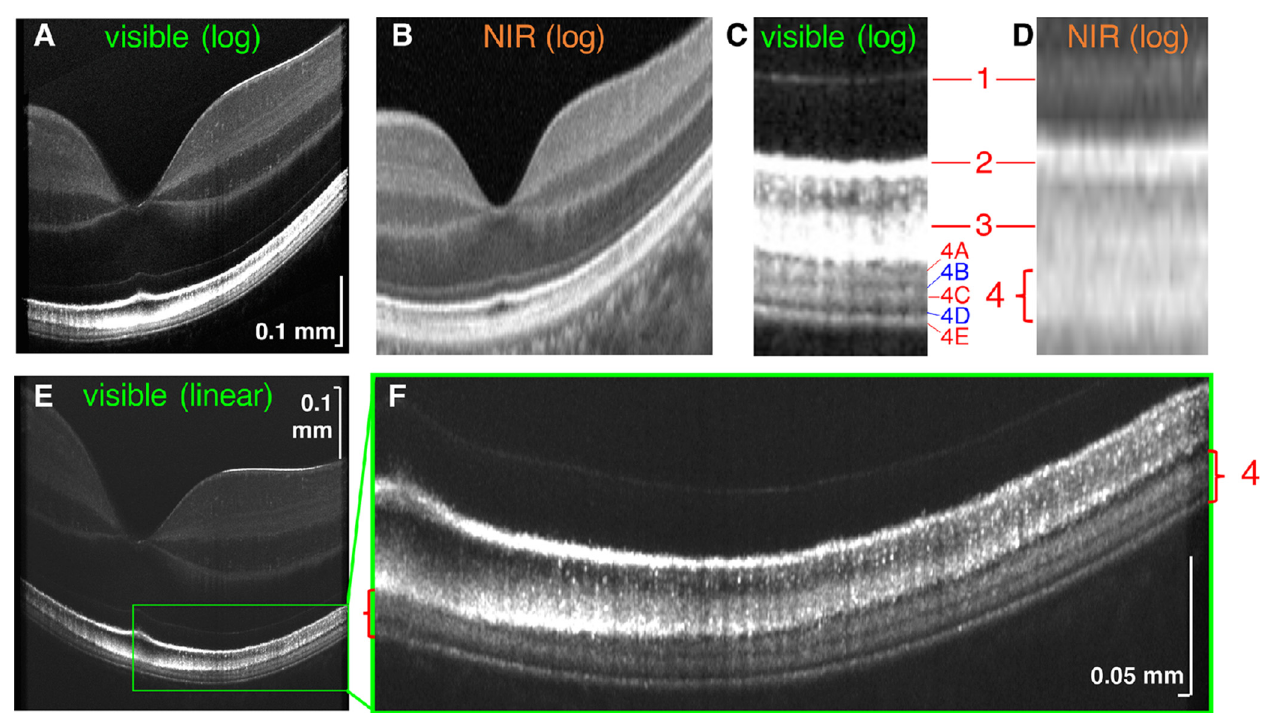
Figure 1. Visible light OCT (vis-OCT) imaging. Side-by-side comparison of vis-OCT ( A ) and commercial NIR-based OCT ( B ). ( C ) Magnified vis-OCT that shows outer retinal bands 1–4, with segmented hyperreflective bands and hyporeflective zones in outer retinal band 4, compared to magnified commercial NIR-based OCT ( D ). ( E , F ) Vis-OCT (linear scale). Reprinted with permission from Zhang et al. [18] . Visible Light Optical Coherence Tomography (OCT) Quantifies Subcellular Contributions to Outer Retinal Band 4. Transl. Vis Sci. Technol. 2021;10(3):30. with license permis-